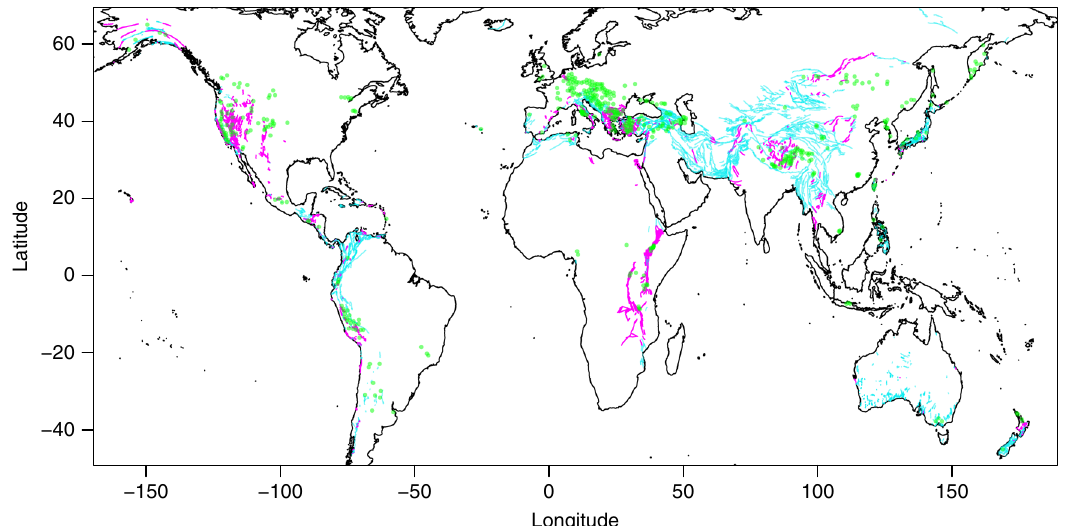
Fig. 2 Earth degassing distribution and active faults. Distribution of carbon dioxide discharges (green dots) and active faults with (magenta lines) and without (turquoise lines) normal